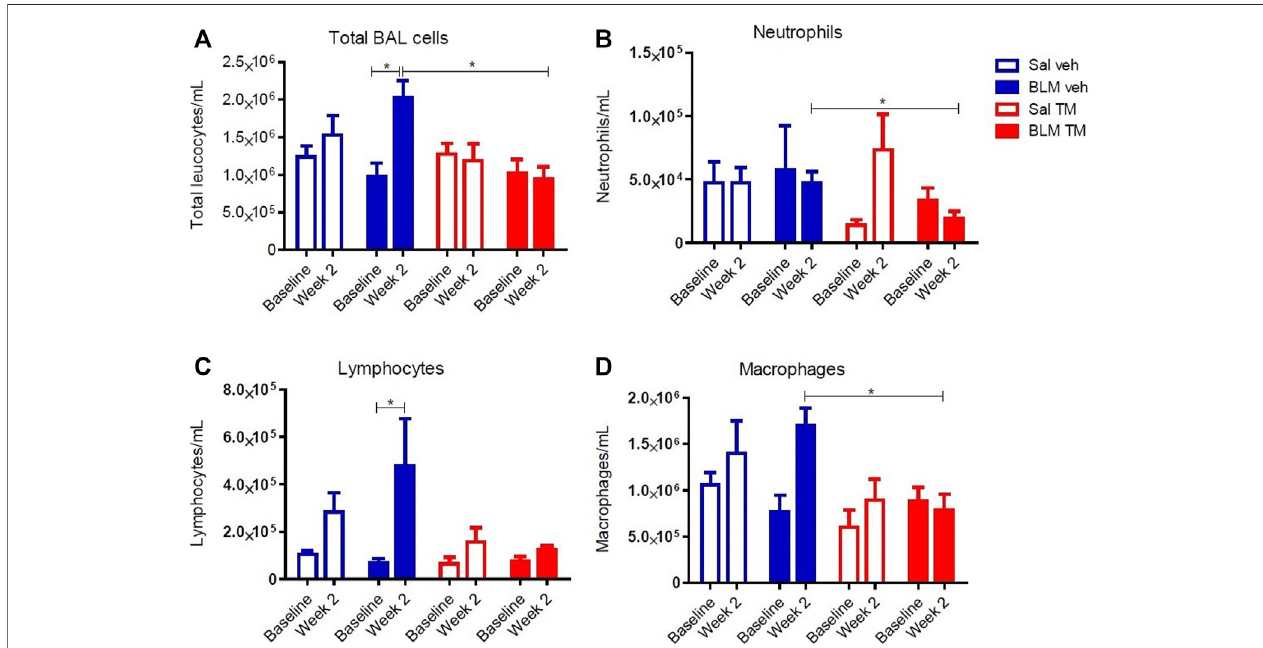
FIGURE 5 | Total and differential leukocyte counts in BAL fl uid. Total and differential leukocyte counts were performed on BAL cells collected from saline- and bleomycin-infused segments in sheep both prior to, and 2 weeks following the fi nal infusion. (A) Total BAL cells, (B) Neutrophils, (C) Lymphocytes, and (D) Macrophages. Signi fi cance was determined using a paired t -test between segments from the same treatment group and an unpaired t -test between segments from different groups, * p < 0.05. Values are the mean ( ± SEM), n (cid:1) 10 sheep.